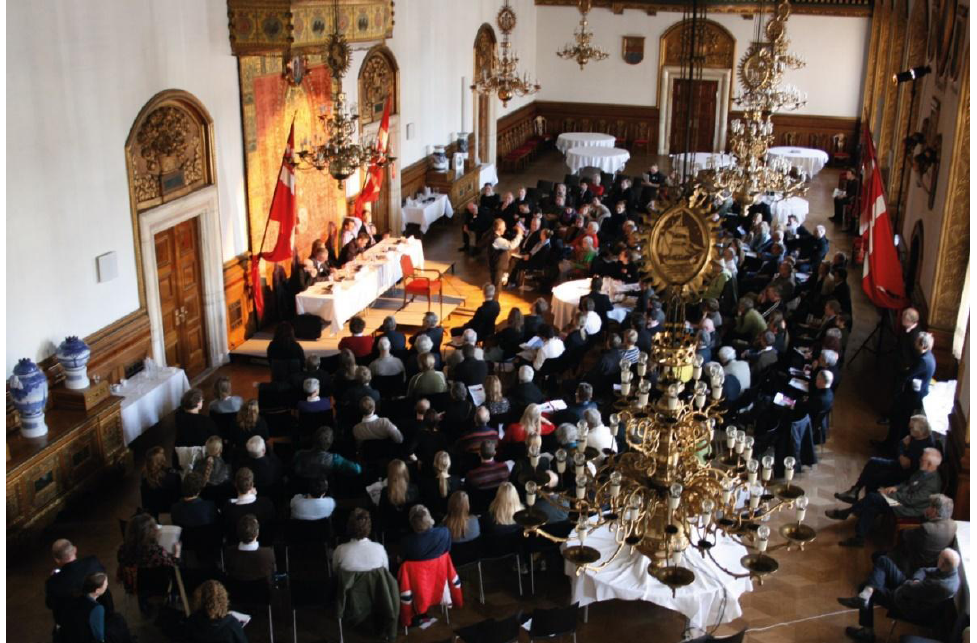
Figure 4. Free Trial! in the ceremonial core of the Copenhagen town hall: Hearing on the high‐rise strategy in March 2007. Source: Courtesy of